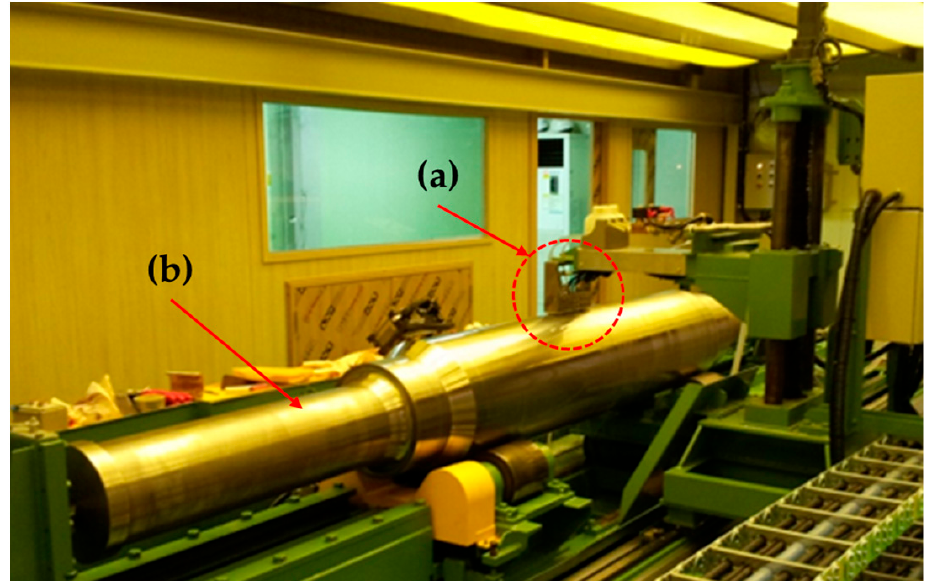
Figure 1. Ultrasonic inspection system for work rolls: ( a ) sensor module and ( b ) work roll.